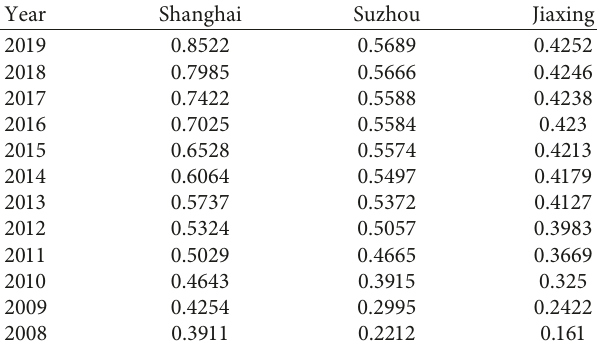
Table 3: Comprehensive innovation development levels of three cities